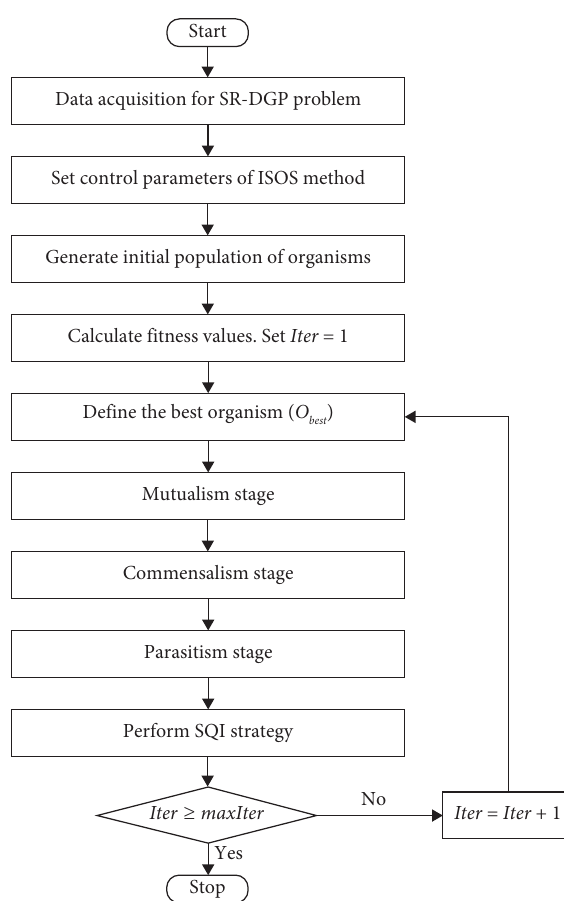
Figure 1: Flowchart of ISOS for dealing with SR-DGP